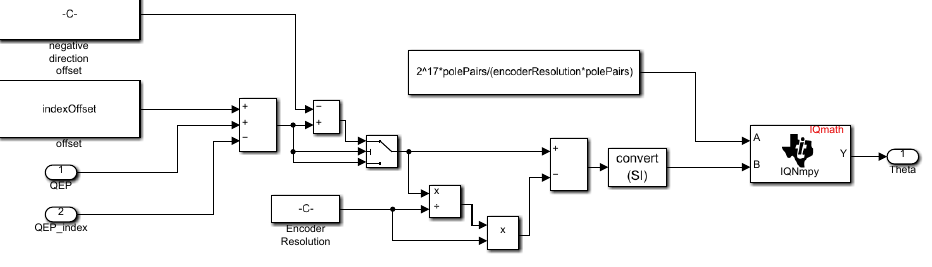
Figure 5. Electrical Angle calculation model.